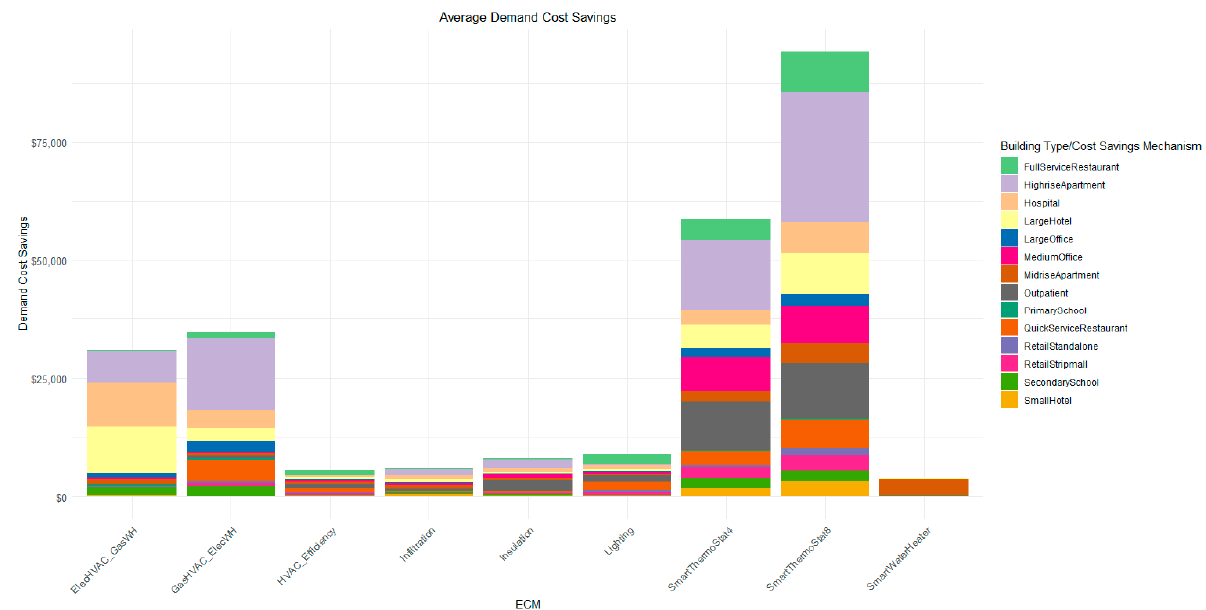
Figure 14. Average demand-related electricity cost savings by building type can indicate cost-conscious opportunities for short-term wins in demand management.